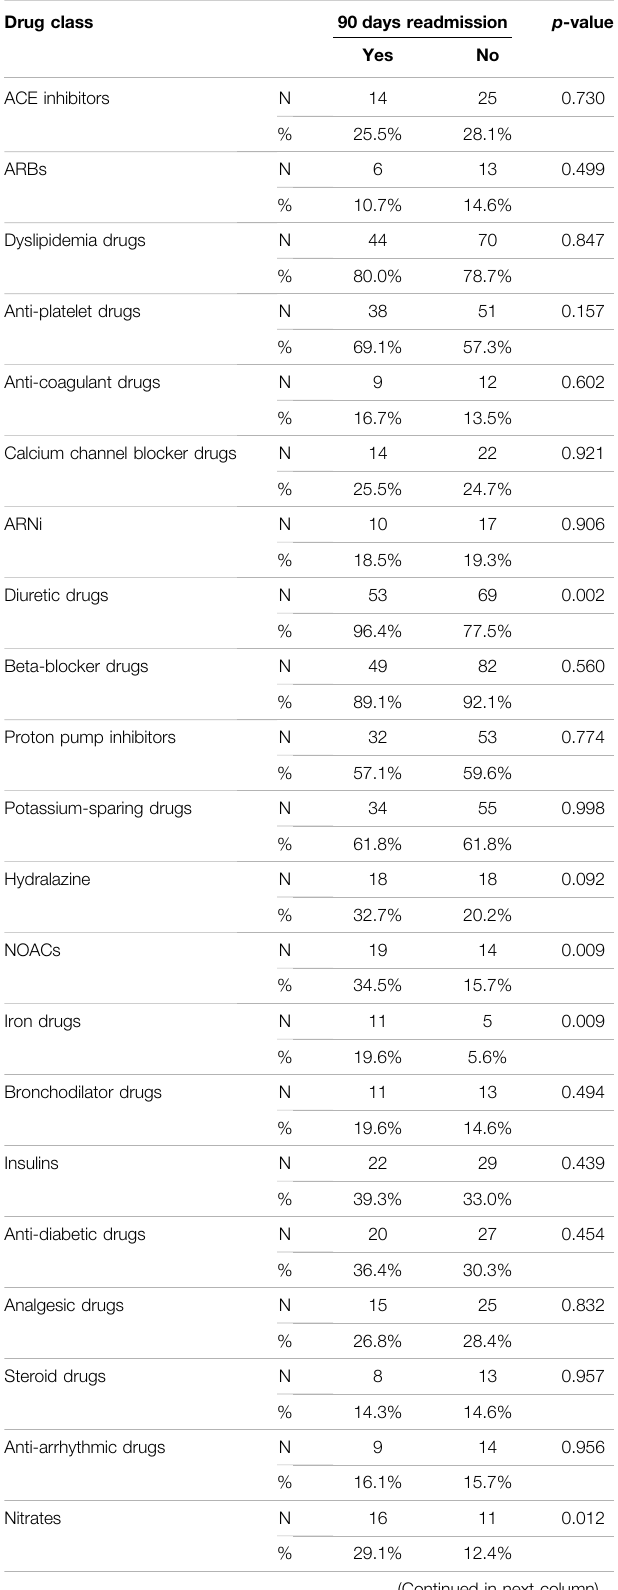
OR: odds ratio, CI: con fi dence